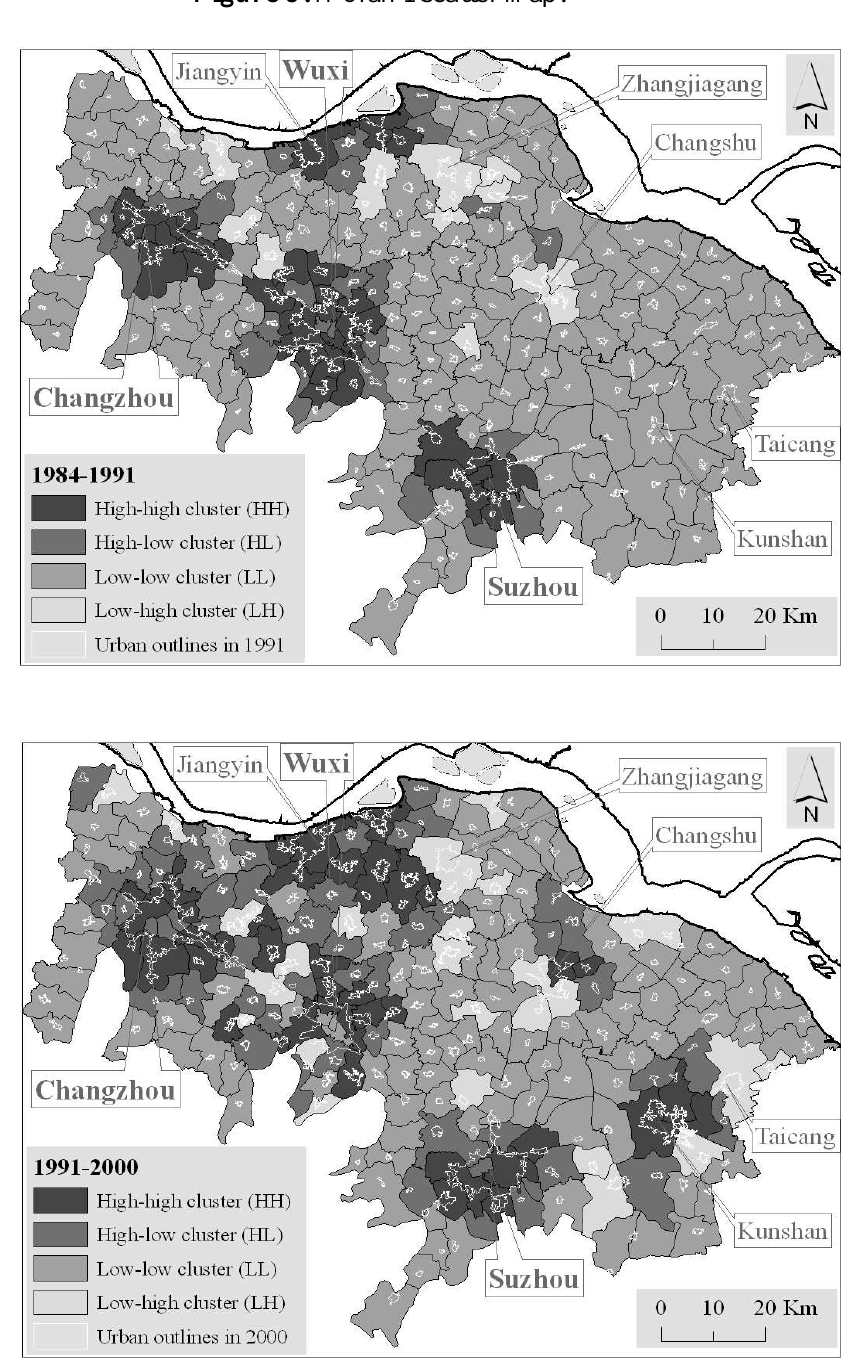
Figure 9. Moran I scatter